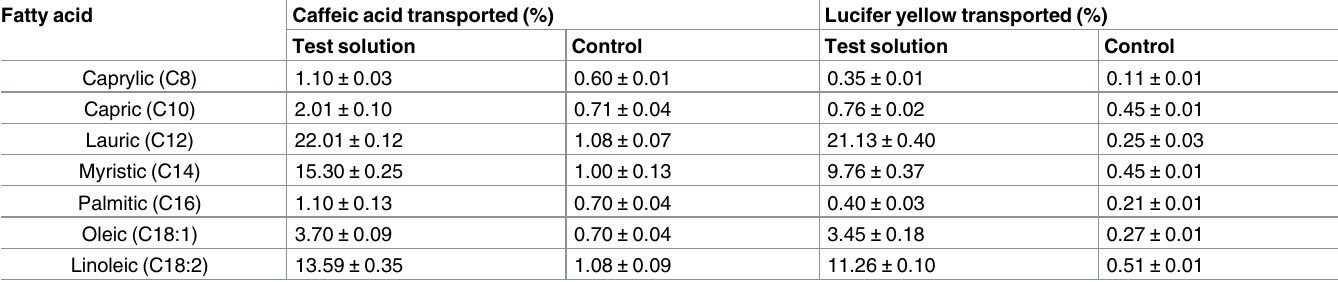
Table 1. Transport percentages of caffeic acid and lucifer yellow after 1 hr of transport through a Caco-2 cell